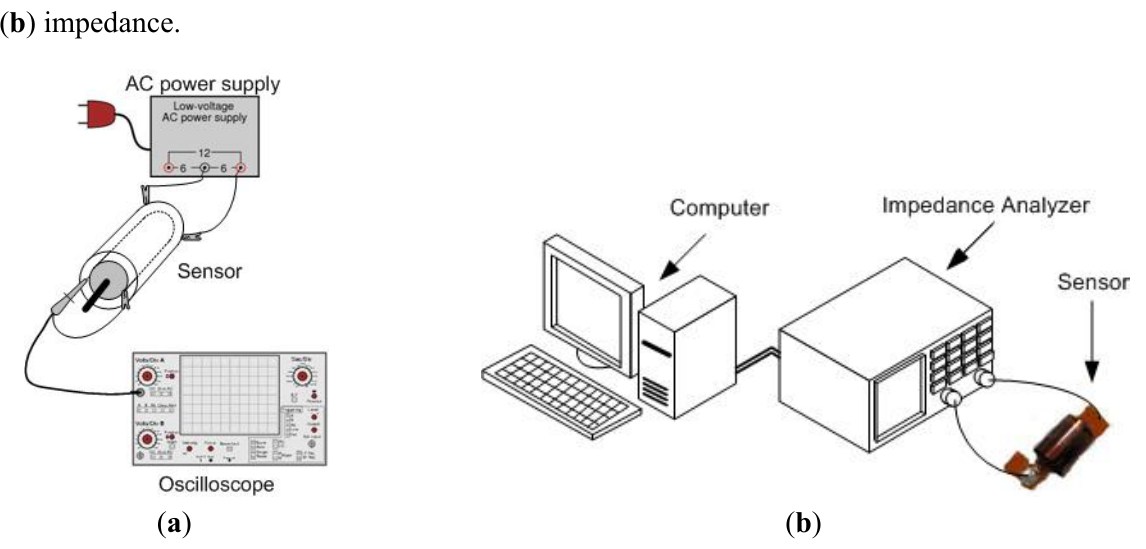
Figure 8. Illustration of the experimental setup for measuring ( a ) mutual inductance and ( b ) impedance.